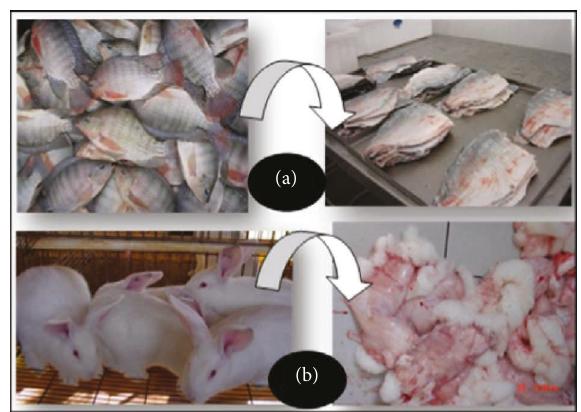
Figure 1: Rabbit and Nile tilapia skins are commonly discarded or underutilized. (a) Nile tilapia skins after skinning and (b) rabbit skins after skinning, with the hypodermic layer to the